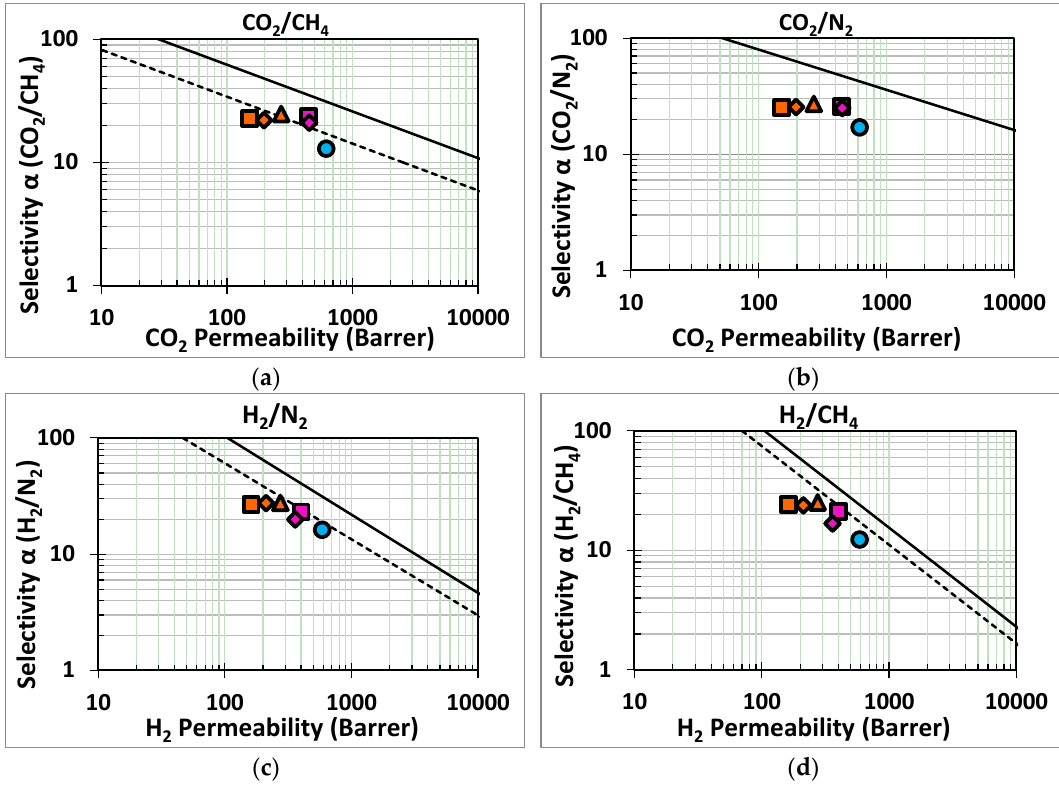
H Permeability 2 Membranes 2017 , 7 , 7 Figure 11. Robeson’s plots for four gas pairs of industrial interest. The dashed line and the solid line Figure 11. Robeson’s plots for four gas pairs of industrial interest. The dashed line and the solid line Figure 11. Robeson’s plots for four gas pairs of industrial interest. The dashed line and the solid line Figure 11. Robeson’s plots for four gas pairs of industrial interest. The dashed line and the solid line Figure 11. Robeson’s plots for four gas pairs of industrial interest. The dashed line and the solid Figure 11. Robeson’s plots for four gas pairs of industrial interest. The dashed line and the solid line represents the Robeson 1991 upper bound [1] and the 2008 upper bound [2], respectively. Samples: represents the Robeson 1991 upper bound [1] and the 2008 upper bound [2], respectively. Samples: represents the Robeson 1991 upper bound [1] and the 2008 upper bound [2], respectively. Samples: represents the Robeson 1991 upper bound [1] and the 2008 upper bound [2], respectively. Samples: line represents the Robeson 1991 upper bound [1] and the 2008 upper bound [2], respectively. Figure 11. Robeson’s plots for four gas pairs of industrial interest. The dashed line and the solid line represents the Robeson 1991 upper bound [1] and the 2008 upper bound [2], respectively. Samples: HMDA-PIM1 ( ); orange series: HKUST-1/BTC/HMDA-PIM1 after 1( ), 3( ) and 5( ) days of Samples: HMDA-PIM1 ( ); orange series: HKUST-1/BTC/HMDA-PIM1 after 1( HMDA-PIM1 ( ); orange series: HKUST-1/BTC/HMDA-PIM1 after 1( ), 3( ) and 5( ) days of represents the Robeson 1991 upper bound [1] and the 2008 upper bound [2], respectively. Samples: HMDA-PIM1 ( ); orange series: HKUST-1/BTC/HMDA-PIM1 after 1( ), 3( ) and 5( ) days of HMDA-PIM1 ( ); orange series: HKUST-1/BTC/HMDA-PIM1 after 1( ), 3( ) and 5( ) days of HMDA-PIM1 ( ); orange series: HKUST-1/BTC/HMDA-PIM1 after 1( ), 3( ) and 5( ) days of ) days HKUST-1 growth; purple series: HKUST-1/HMDA-PIM1 after 3( ) and 5( ) days of HKUST-1 HKUST-1 growth; purple series: HKUST-1/HMDA-PIM1 after 3( ) and 5( HMDA-PIM1 ( ); orange series: HKUST-1/BTC/HMDA-PIM1 after 1( ), 3( ) and 5( HKUST-1 growth; purple series: HKUST-1/HMDA-PIM1 after 3( ) and 5( ) days of HKUST-1 HKUST-1 growth; purple series: HKUST-1/HMDA-PIM1 after 3( ) and 5( ) days of HKUST-1 HKUST-1 growth; purple series: HKUST-1/HMDA-PIM1 after 3( ) and 5( ) days of HKUST-1 of HKUST-1 growth. growth. growth. HKUST-1 growth; purple series: HKUST-1/HMDA-PIM1 after 3( ) and 5( growth.